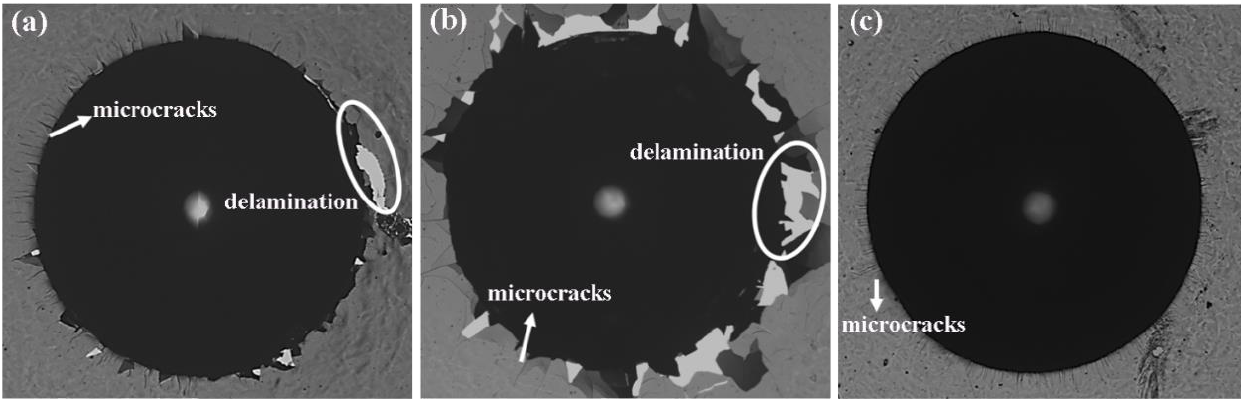
Figure 9. Reference standard for the evaluation of adhesion.